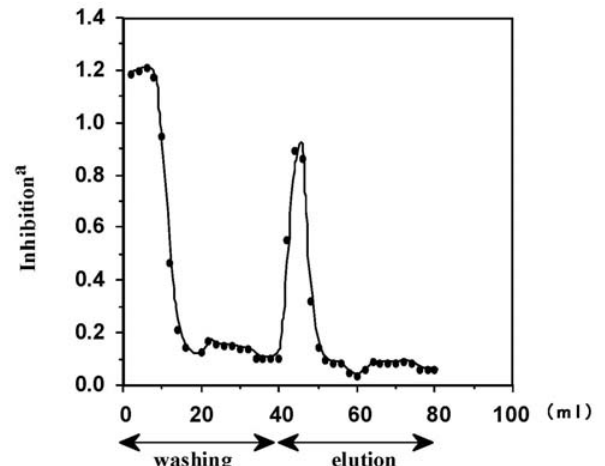
Figure 5. Elution profile of Panax ginseng crude extract on immunoaffinity column monitoring by ELISA using anti-ginsenoside-Rb1